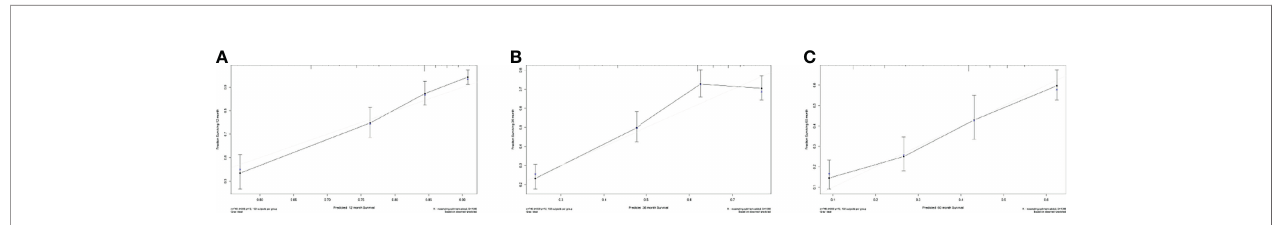
FIGURE 5 | Calibration curves for evaluating the accuracy of the nomogram. (A) 1-year CSS in lymph-node-negative women with DM, (B) 3-year CSS in lymph- node-negative women with DM, and (C) 5-year CSS in lymph-node-negative women with DM. The solid black line represents the performance of the nomogram, of which the closer fi t to the gray line represents the better prediction of the nomogram we constructed. CSS, cancer-speci fi c